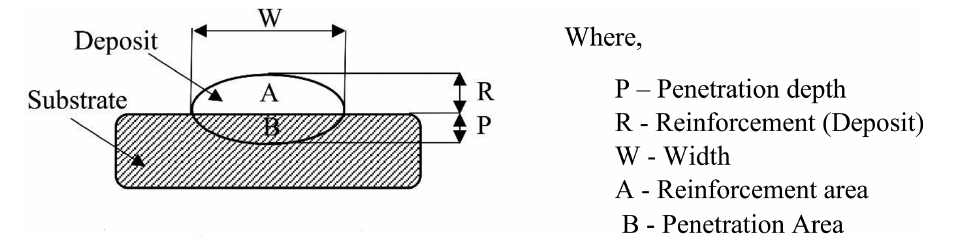
Figure 2: Bead profile and bead